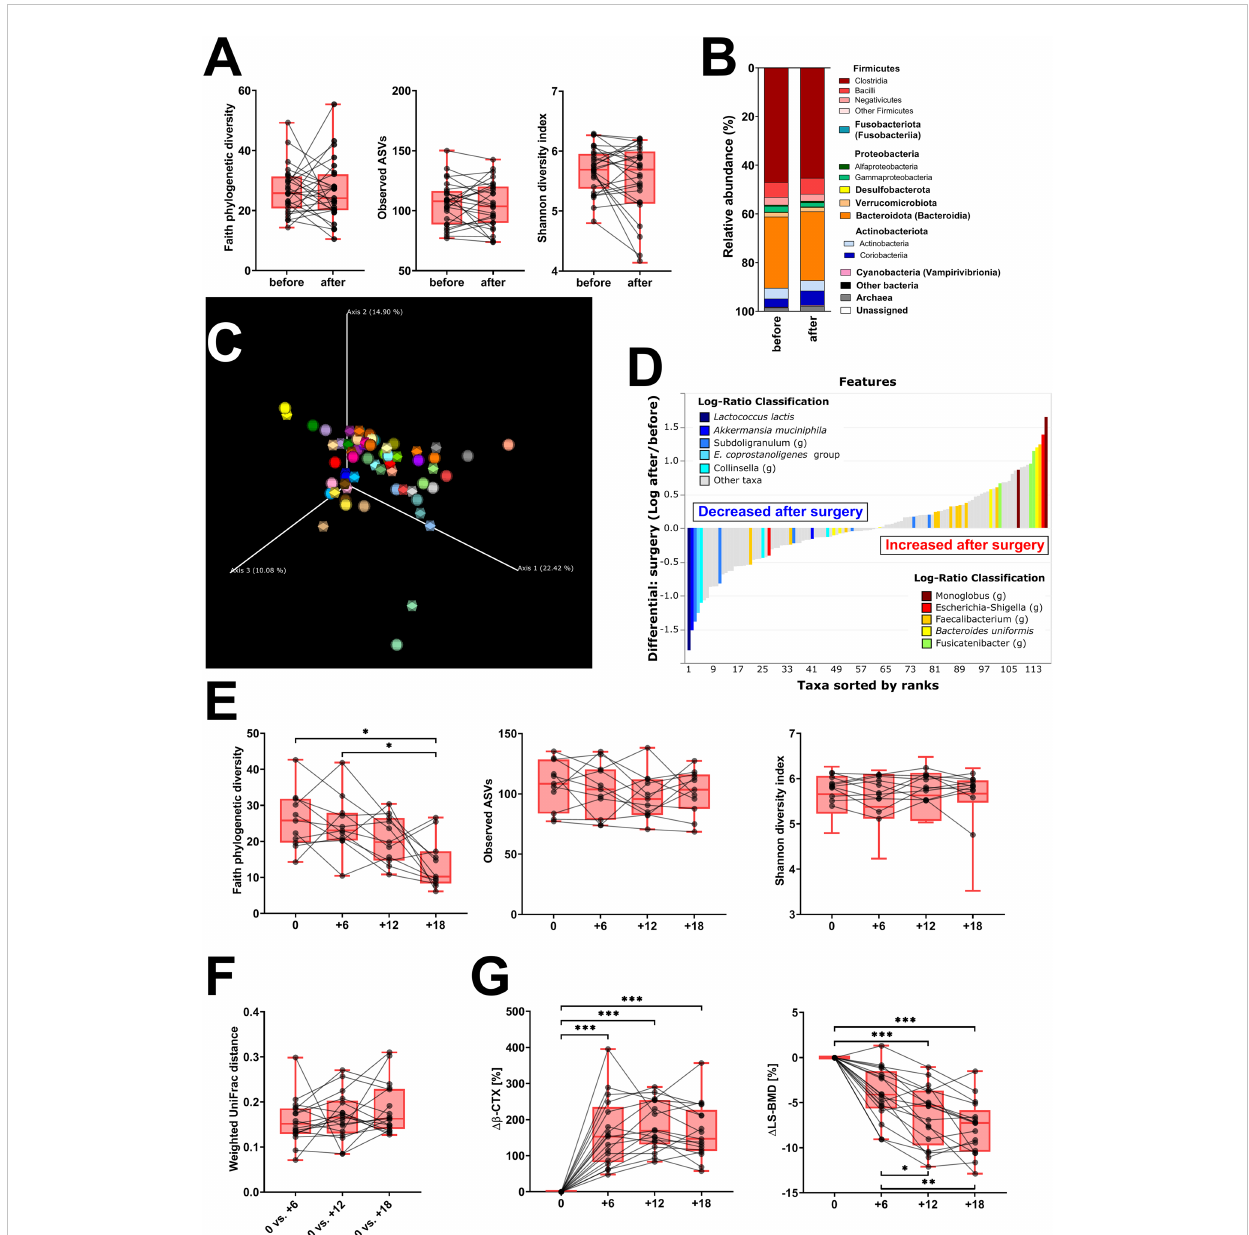
FIGURE 2 Fecal bacteria composition is not markedly changed by surgery. (A) Changes in a -diversity after surgery were characterized by the metrics Faith ’ s phylogenetic diversity, observed features, and Shannon diversity index. (B) b -Diversity comparison at the class level. (C) Principal coordinate analysis (PCoA) plot using the weighted UniFrac distance metric shows the fecal microbiota compositional differences induced by surgery. The time point before surgery is shown as a sphere and the time point after surgery as an icosahedron, and the same color represents the same patient. (D) Differential rankings of taxa associated with the patient ’ s status related to surgery with ranks estimated from multinomial regression with the top 5 species/genera related to each state highlighted. (E) Changes in a -diversity 6, 12, and 18 months after surgery; (F) changes in weighted UniFrac distances from the time before surgery; and (G) serum change in b -CTX ( Db -CTX) and lumbar spine density ( D LS-BMD) in the same time points. For a -diversity analyses, rarefaction was performed at 2,020 reads, and patients with lower yields in one time point were excluded from the analysis. Groups were compared with the Wilcoxon matched-pairs signed rank test or paired t -test (A) or Friedman test with Dunn ’ s multiple comparison test (E – G) . * p < 0.05; ** p < 0.01; *** p < 0.001. Comparison of all clinical data for these patients is found in Table